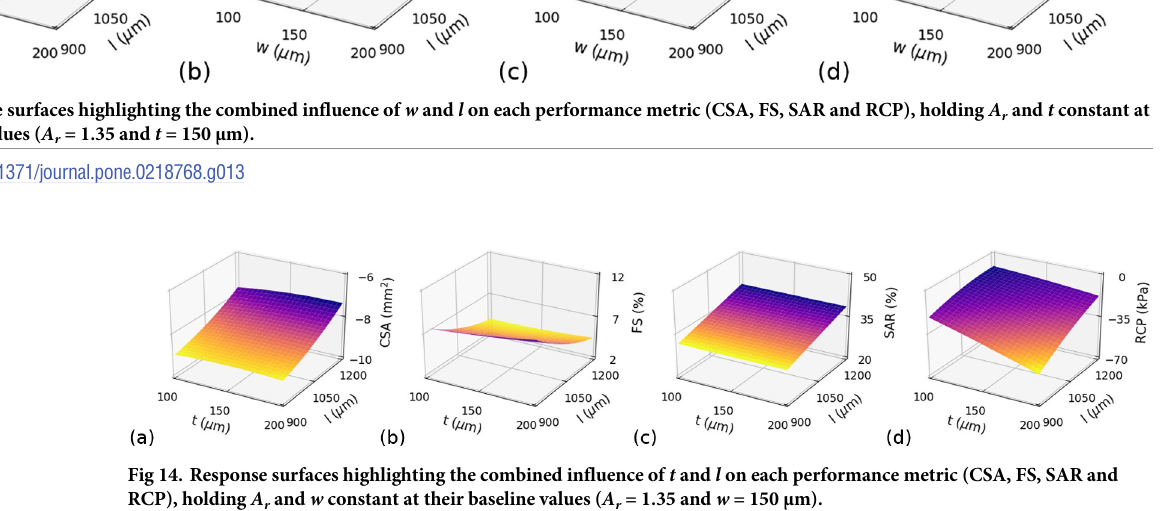
Fig 14. Response surfaces highlighting the combined influence of t and l on each performance metric (CSA, FS, SAR and RCP), holding A r and w constant at their baseline values ( A r = 1.35 and w = 150 μ m).